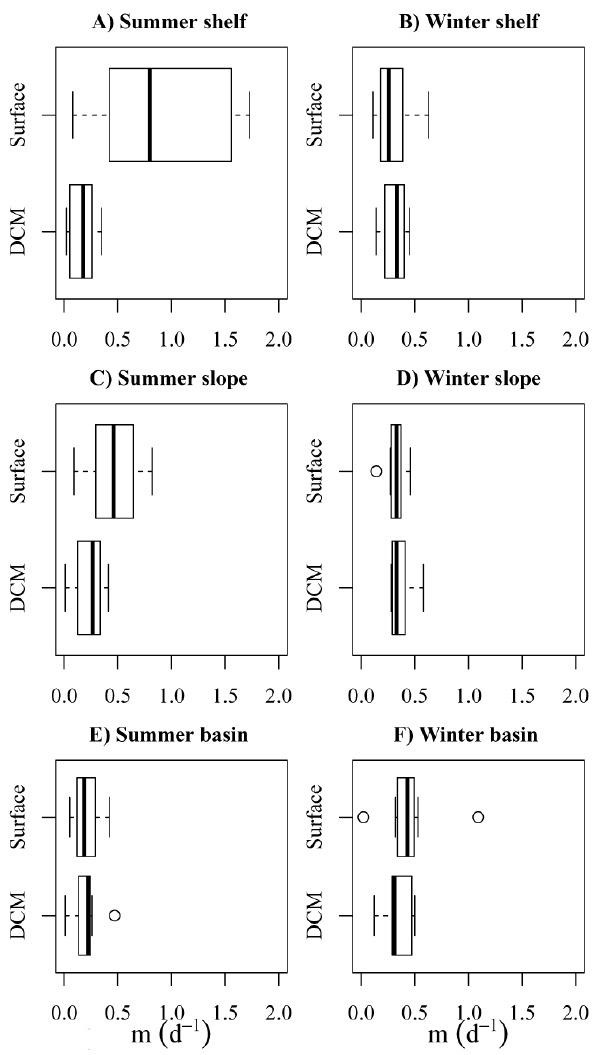
Fig. 5. Box plots of microzooplankton grazing rate ( m) . Fig. 6. Box plots of m / µ 0